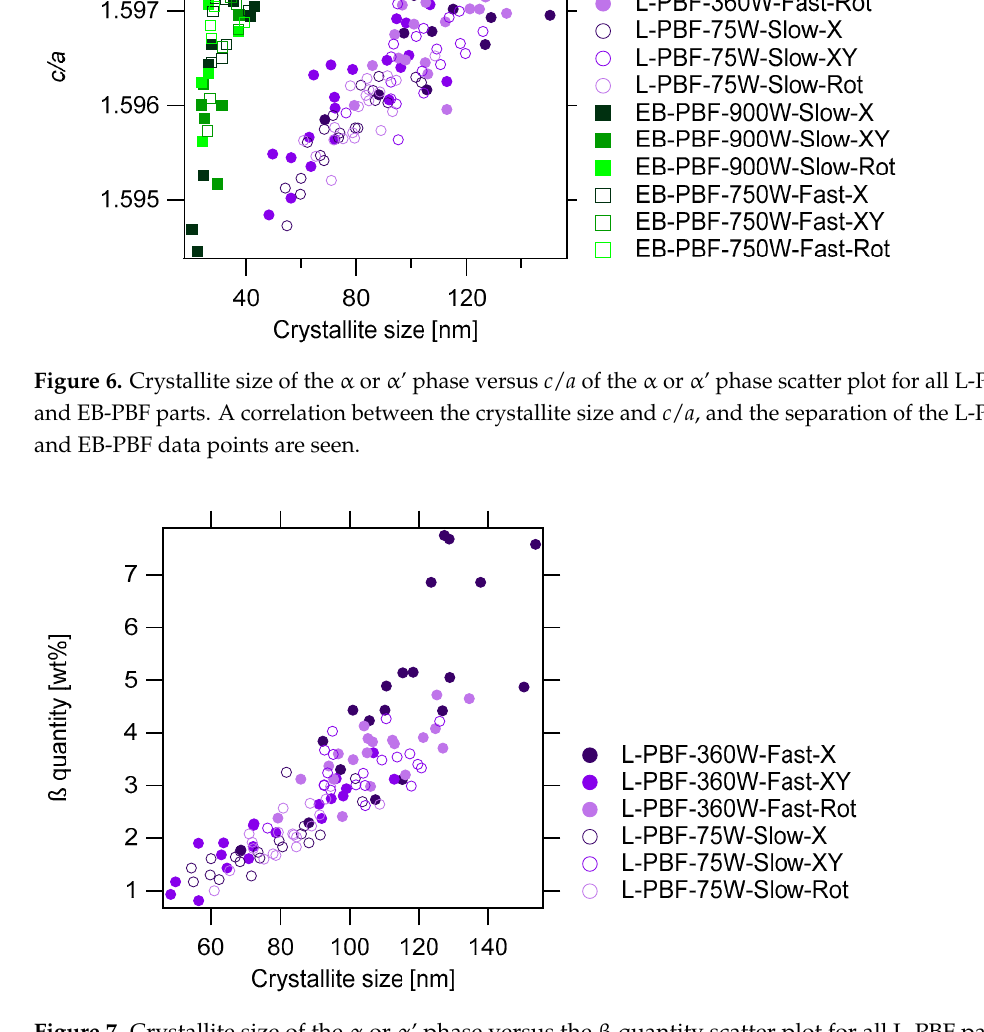
Figure 7. Crystallite size of the α or α ’ phase versus the β quantity scatter plot for all L-PBF parts. A correlation between the crystallite size and the β quantity is seen.